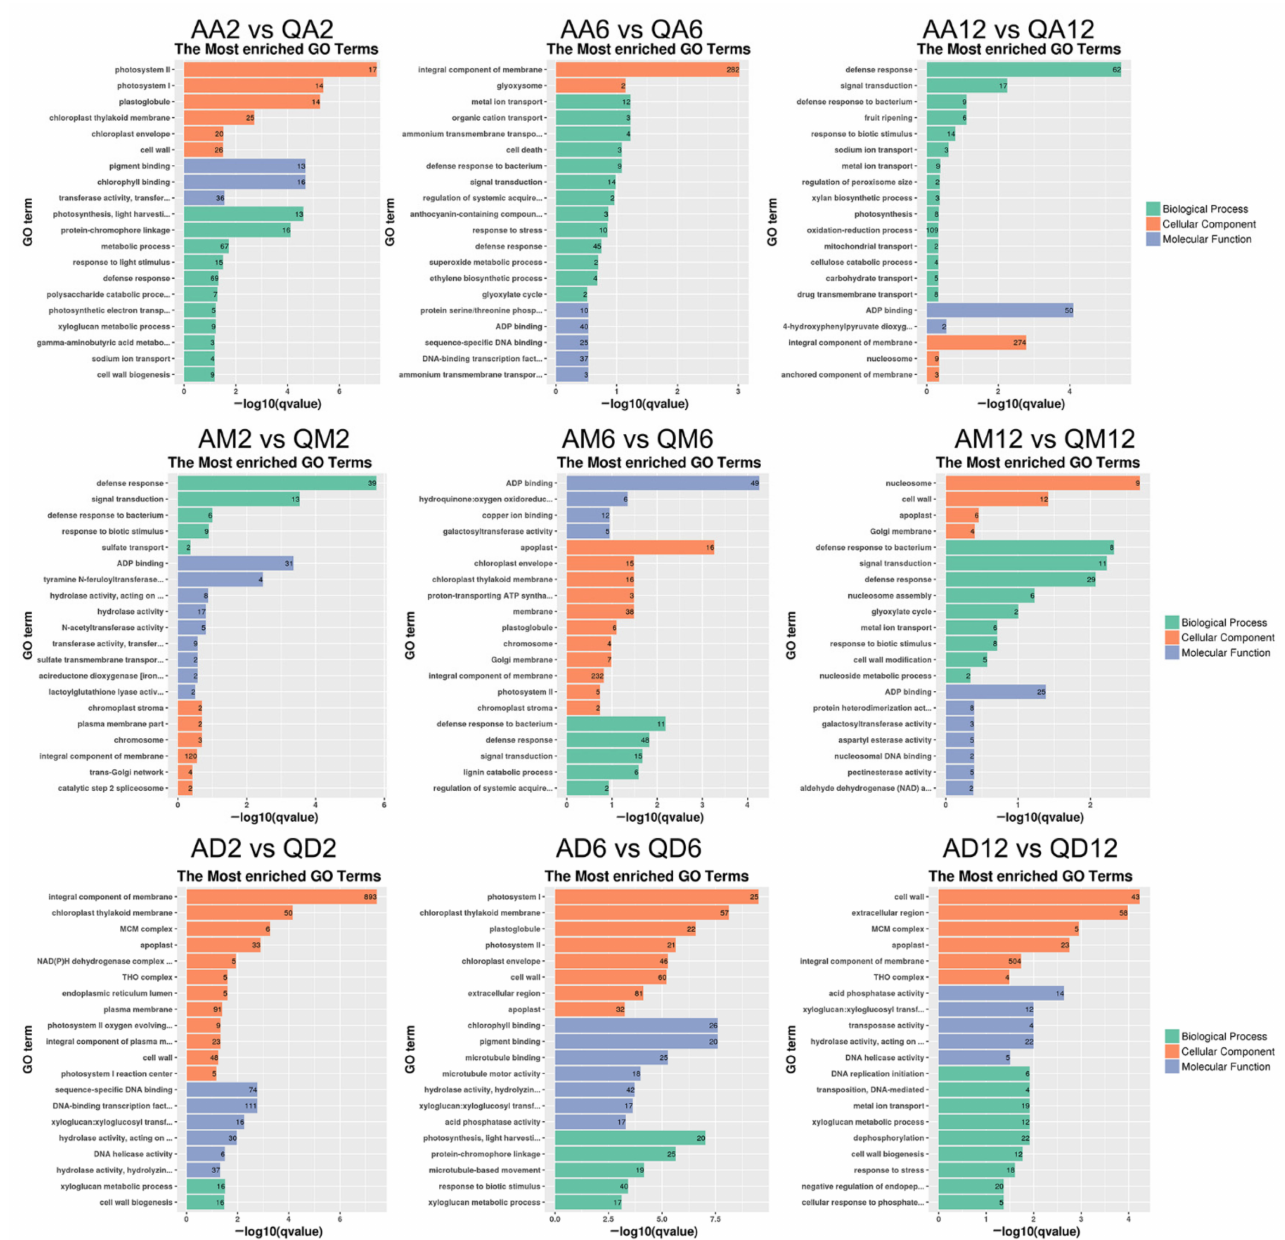
Figure 4. Annotation and functional classification of DEGs’ GO term. Histogram of most enriched GO classifications of potato DEGs under treatment. The ordinate is the enriched GO term; the abscissa is the enriched q value of the term as well as the number of differential genes on the column. Different colors distinguish biological processes, cellular components, and molecular